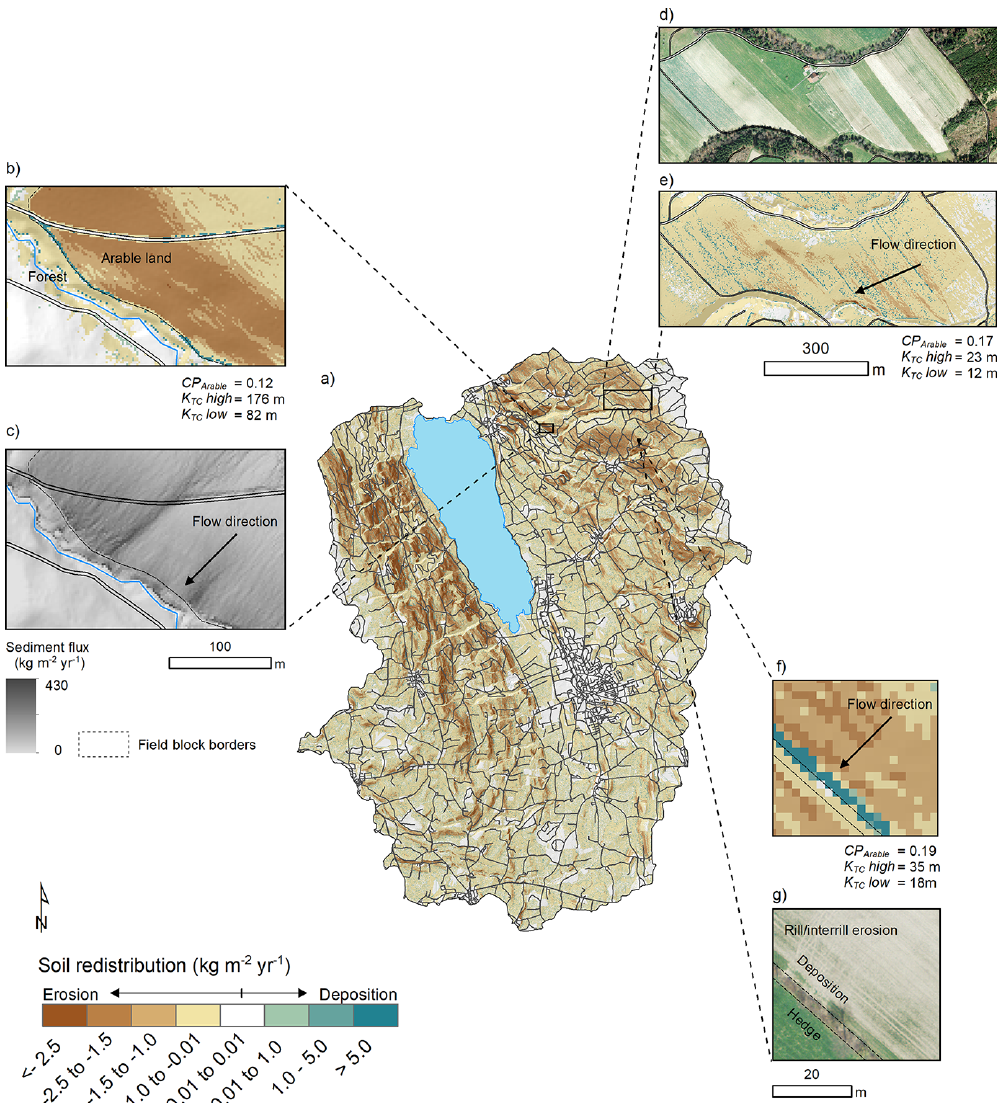
Figure 6. (a) Catchment patterns of soil redistribution for a model realisation with the presence of grass buffer strips. (b) Detail the of sediment deposition on field borders for the road as patch connectors scenario. (c) Detail of the sediment fluxes across the road network for the road as patch connectors scenario. (d) Detail of the aerial image of multiple parcels within a field block (Swisstopo, 2014b). (e) Soil redistribution rates for the field block. (f) Detail of the sediment deposition at a grass buffer strip at a field border. (g) Aerial image of the field (Swisstopo,